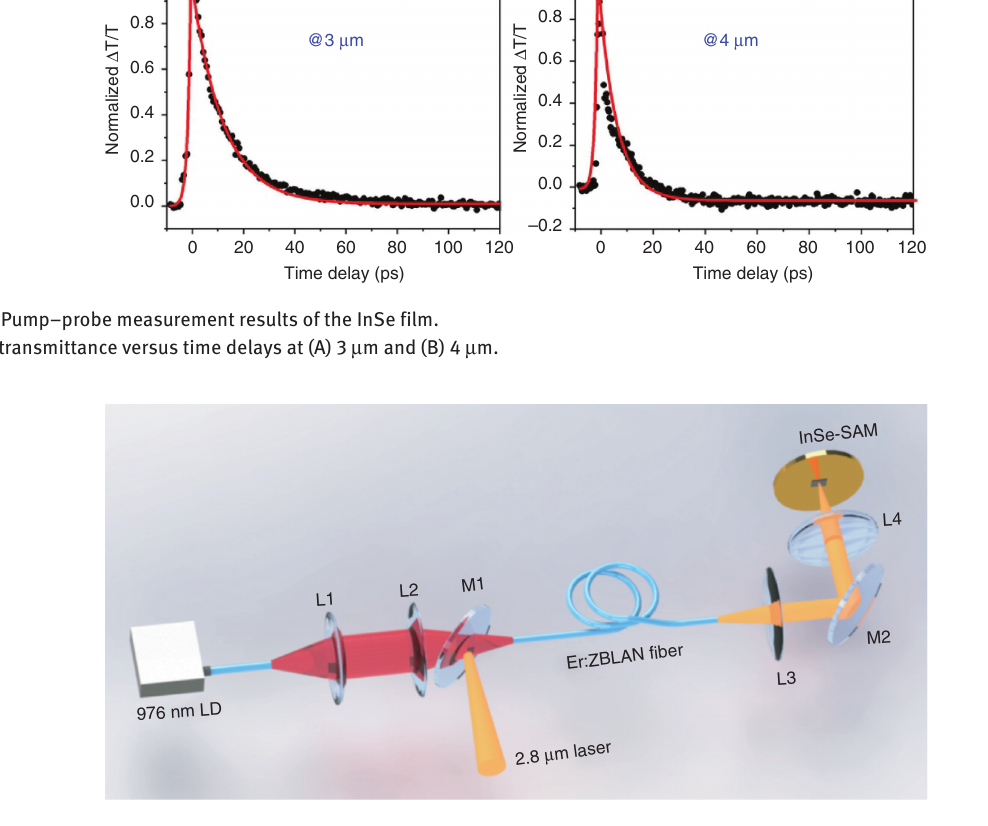
Figure 4: Schematics of Q-switched Er:ZBLAN fiber laser using InSe film as SA. LD, laser diode; L1, L2, L3, and L4, lenses; M1 and M2, dichroic